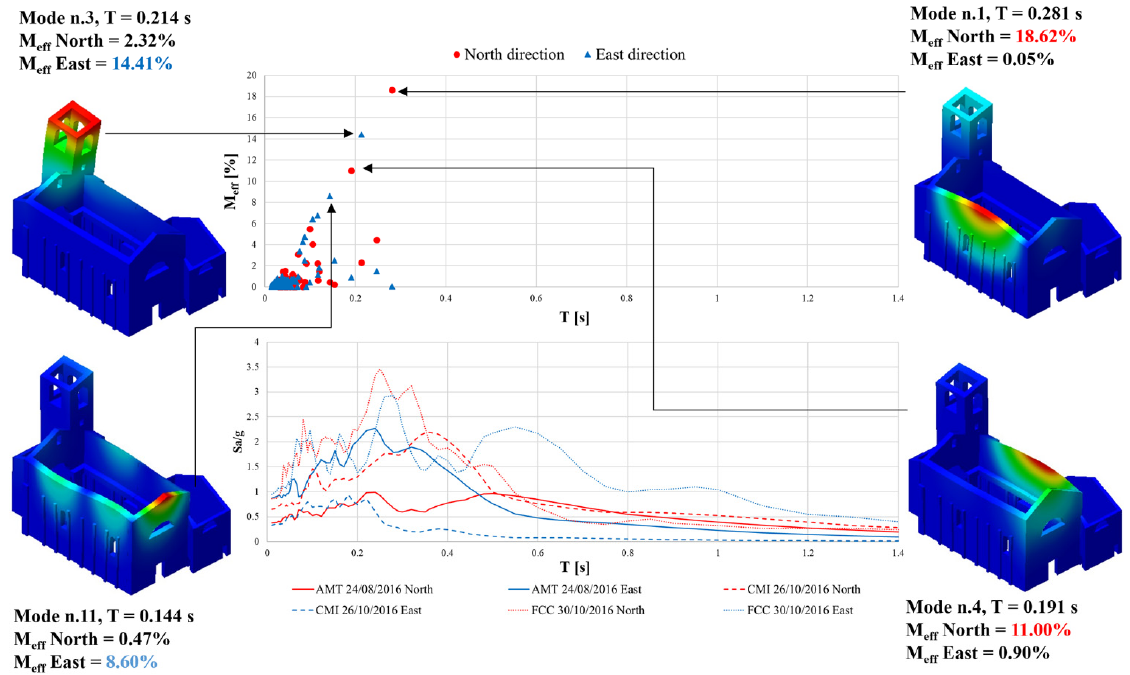
Figure 6. Distribution of modal shapes in the longitudinal and transversal directions and comparison with the pseudo- acceleration response spectra of the three main shocks of Central Italy seismic sequence of 2016 for San Francesco Church in Sarnano (Macerata, Central Italy).